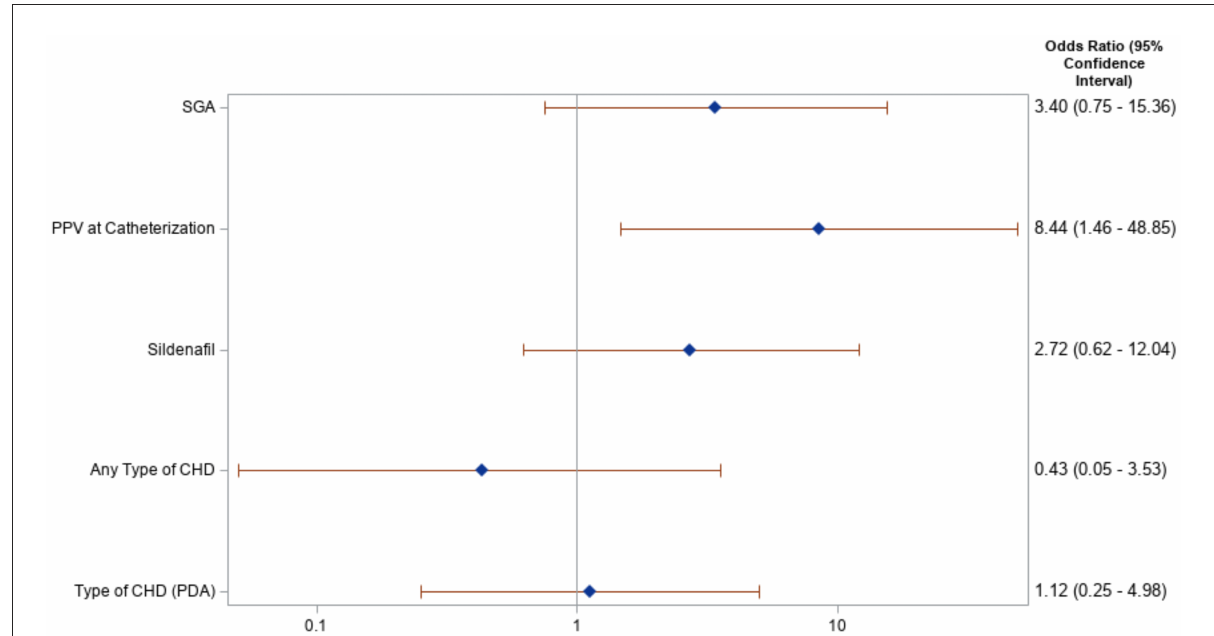
FIGURE1 Forest plot of risk factors for left atrial hypertension: Risk for left atrial hypertension for select clinical factors is demonstrated in this Forest plot, along with associated odds ratio and p-value. Positive pressure ventilation (PPV) was the only variable that demonstrated significant risk for left atrial hypertension. SGA, small for gestational age; PPV, positive pressure ventilation; CHD, congenital heart disease; PDA, patent ductus arteriosus.